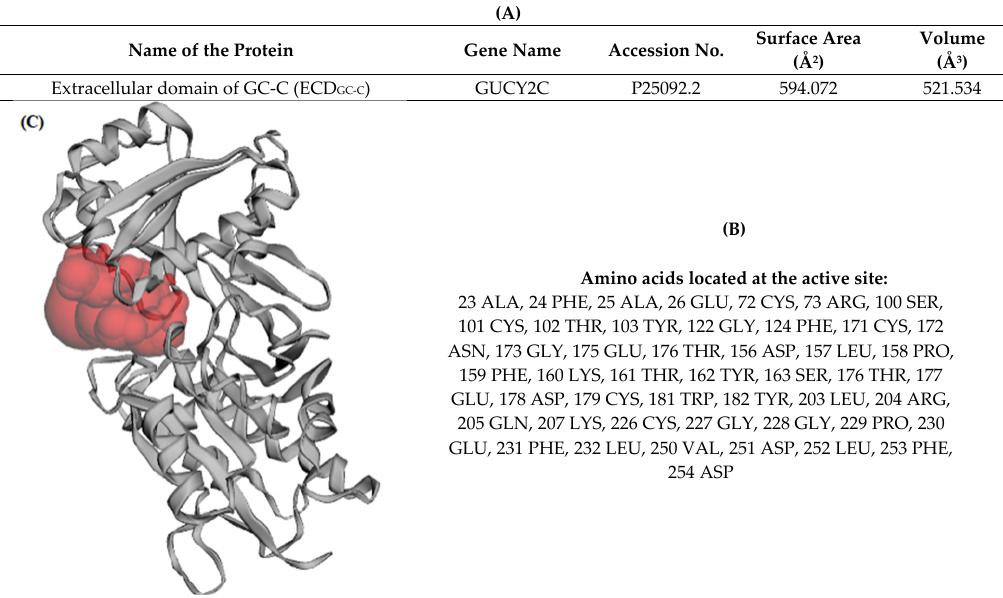
Figure 4. Active site prediction of extracellular domain (ECD) through CASTp. ( A ) Area and volume of the active site. ( B ) Amino acids located at the active site. ( C ) 3D structure of the active